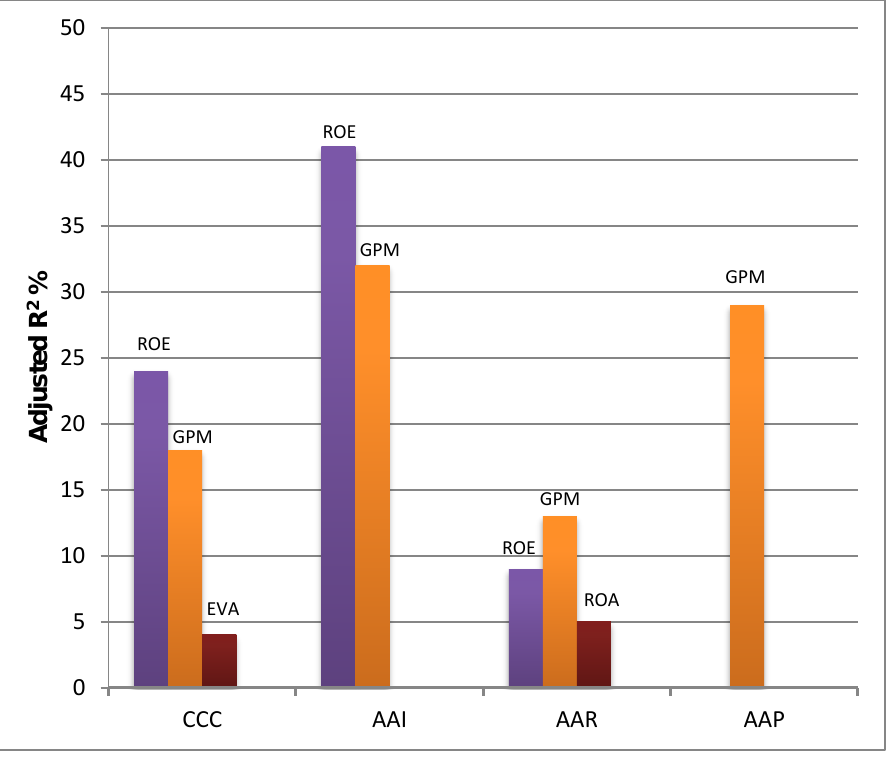
FIGURE 1: Effect of working capital on profitability Source: Author’s